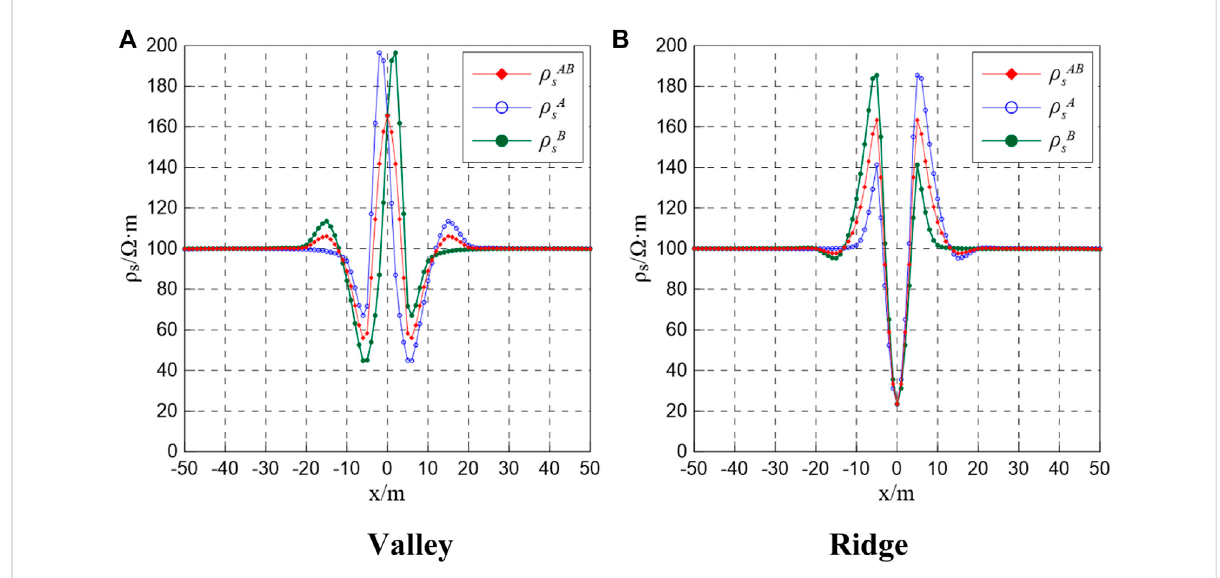
FIGURE 6 Line source joint pro fi le anomaly curves for (A) valley and (B) ridge.